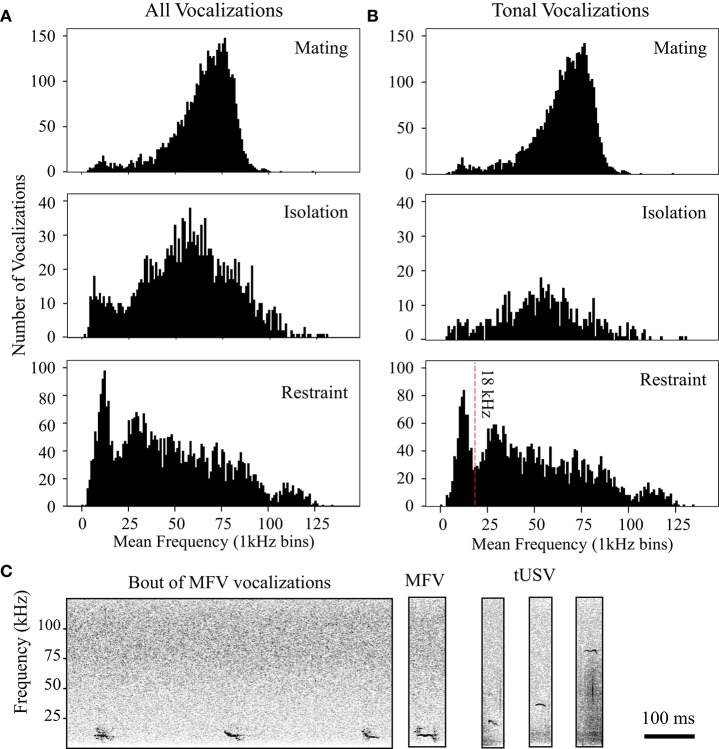
Distribution of peak frequencies in vocalizations changes with context. (A) Histograms display peak frequencies of all vocalizations emitted in each context. (B) Histograms show distribution of tonal vocalizations emitted in each context. Vertical red line at 18 kHz in restraint histogram indicates criterion used to delineate Mid-Frequency Vocalization (MFV) from tUSVs. All histograms utilize 1 kHz bins. (C) Left, spectrograms of mid-frequency tonal vocalizations (MFVs) emitted by restrained mice. Right, MFV, and tUSVs emitted by same animal during restraint.